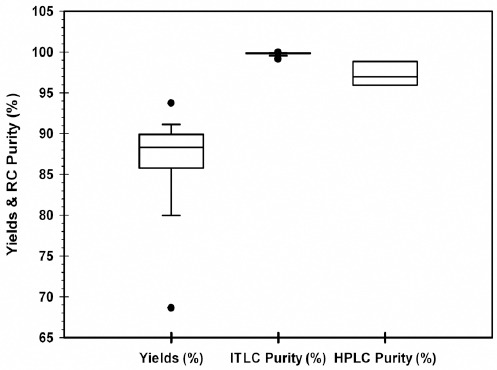
Average [177Lu]-DOTATATE yields and radiochemical (RC) purity by ITLC and HPLC